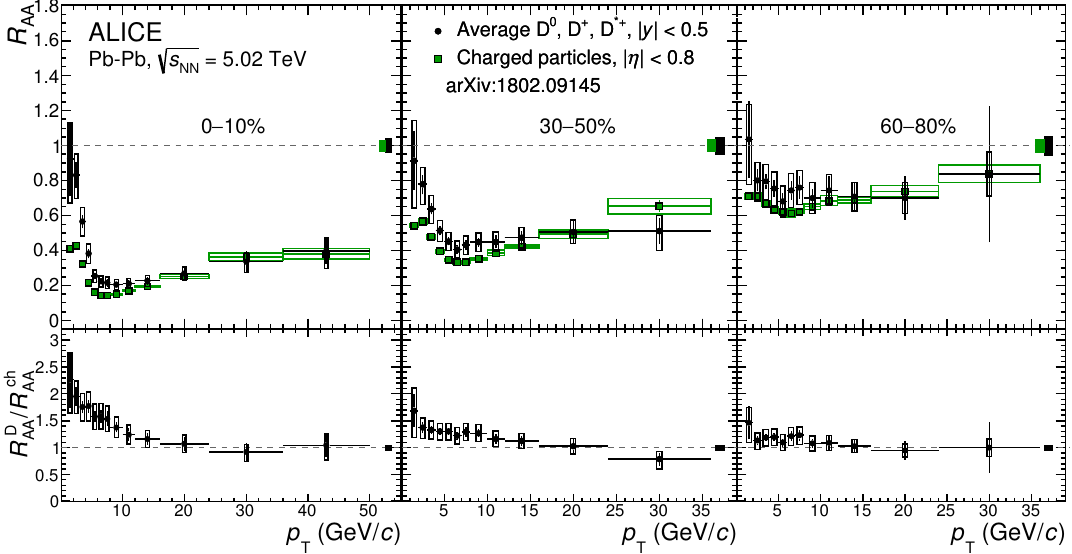
Figure 7 . Average R AA of prompt D 0 , D + and D (cid:3) + mesons in the 0{10% (left), 30{50% (middle) and 60{80% (right) centrality classes at in the same centrality classes [59]. The ratios of the R AA are shown in the bottom panels. Statistical (bars), systematic (empty boxes), and normalisation (shaded box around unity) uncertainties are